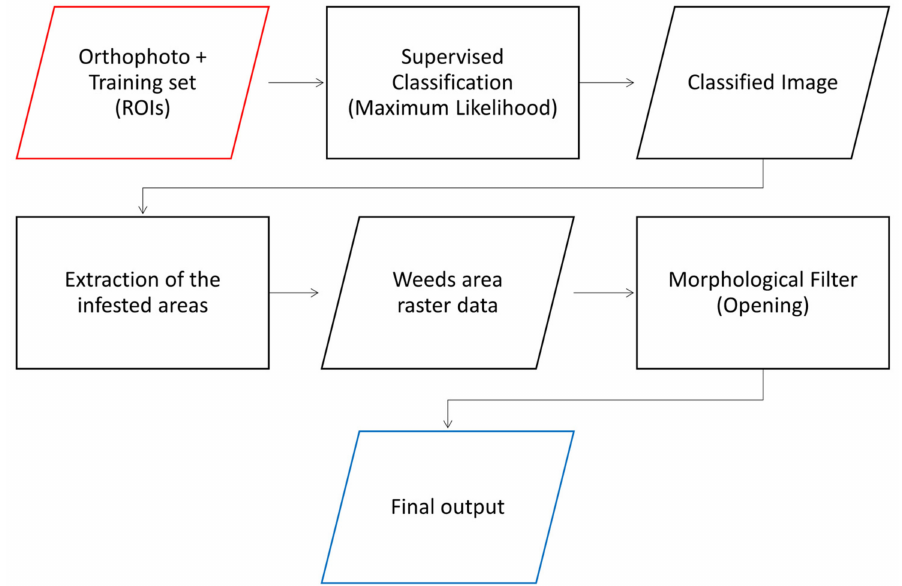
Figure 2. Workflow for Maximum Likelihood classification weed mapping